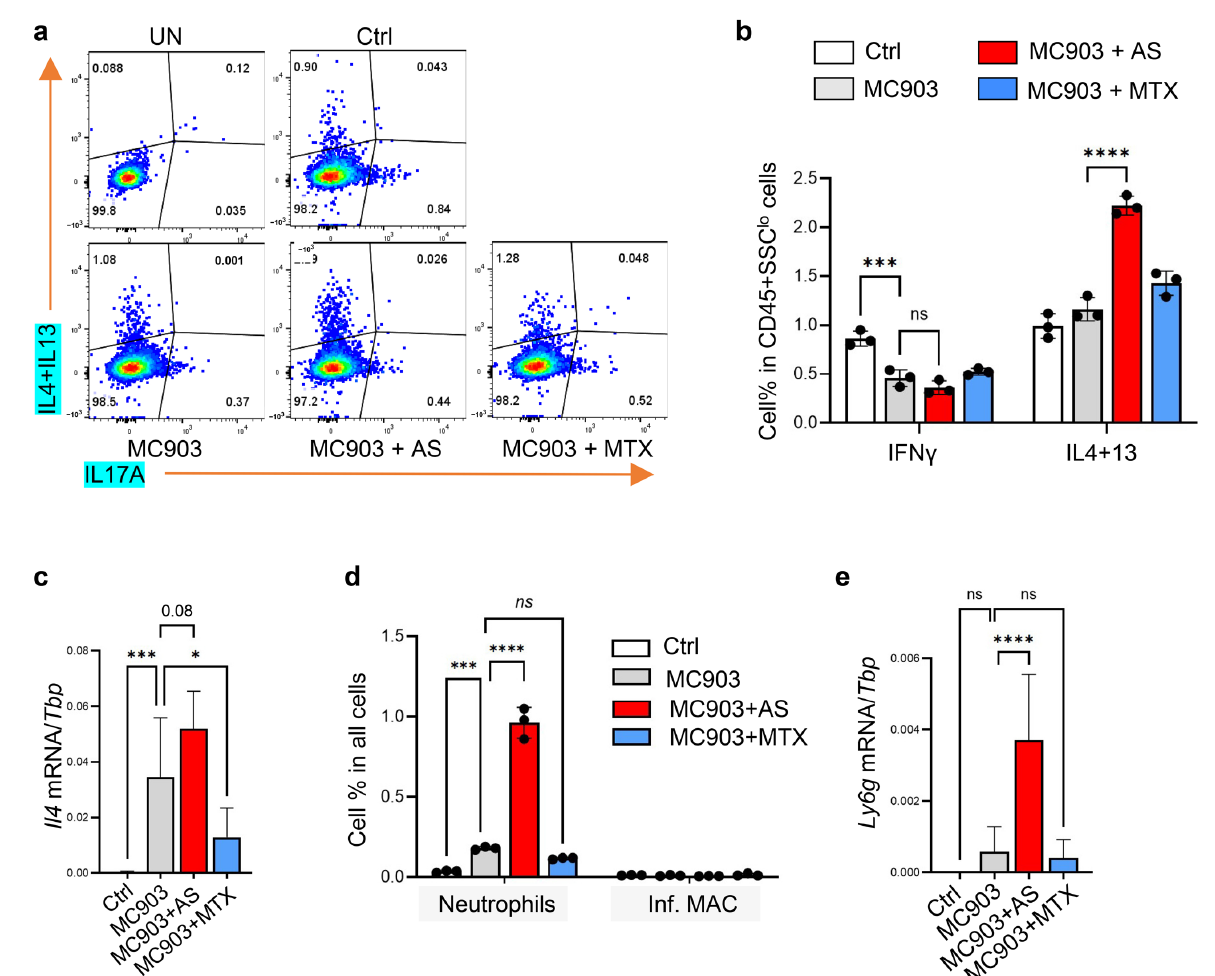
Figure 5. Effect of aluminum salt injection in modulating the MC903-mediated activation of T cells or myeloid cells: ( a , b ) FACS plots (A) and quantified bar graphs ( b ) showing the percentage of IFN γ + or IL4/IL13+ cells in CD45 + SSC lo T cells ( n = 3/group); ( c ) qRT-PCR analysis of the mRNA expression level of Il4 (ratios to HK gene Tbp were shown, n = 6~8/group); ( d ) Bar graphs showing the percentage of neutrophils (CD11B+Ly6G+) and inflammatory macrophages (inf. MAC; F4/80+Ly6C+) in all cells (quantified from FACS plots shown in Figure S5A, n = 3/group). ( e ) qRT- PCR analysis of the mRNA expression level of Ly6g ( n = 6~8/group). All error bars indicate mean ± SEM, and statistical analysis was performed by two- way ANOVA with Bonferroni -corrected mul- tiple comparisons ( b , d ) or one- way ANOVA analysis with Dunnett -corrected multiple comparisons ( c , e ). * p < 0.05, *** p < 0.001, **** p < 0.0001, ns, non-significant.